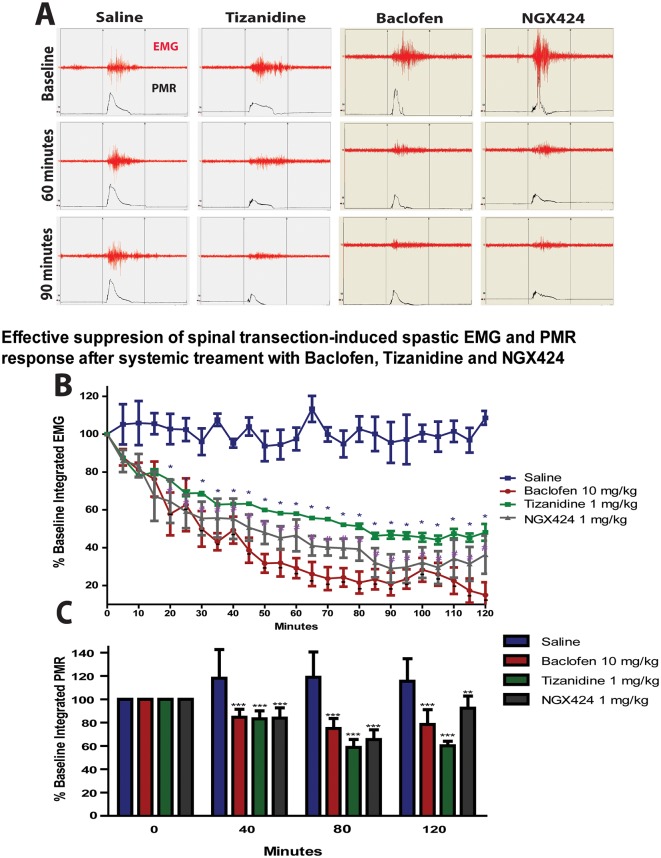
Effective suppression of ankle dorsiflexion-evoked EMG response and muscle resistance after systemic treatment with baclofen, tizanidine and NGX424.
(A)- Representative recording of EMG response (EMG) and corresponding ankle resistance (PMR) in an animal injected systemically with saline, Tizanidine (1mg/kg), baclofen (10mg/kg) or NGX 424 (1mg/kg). (B, C)- Statistical analysis showed significant suppression of EMG response (B) and PMR (C) after treatment will all three drugs if compared to saline treated animals (repeated measures two-way ANOVA, Bonferroni post hoc; *-p< 0.05; **-p< 0.01; ***-p< 0.001).